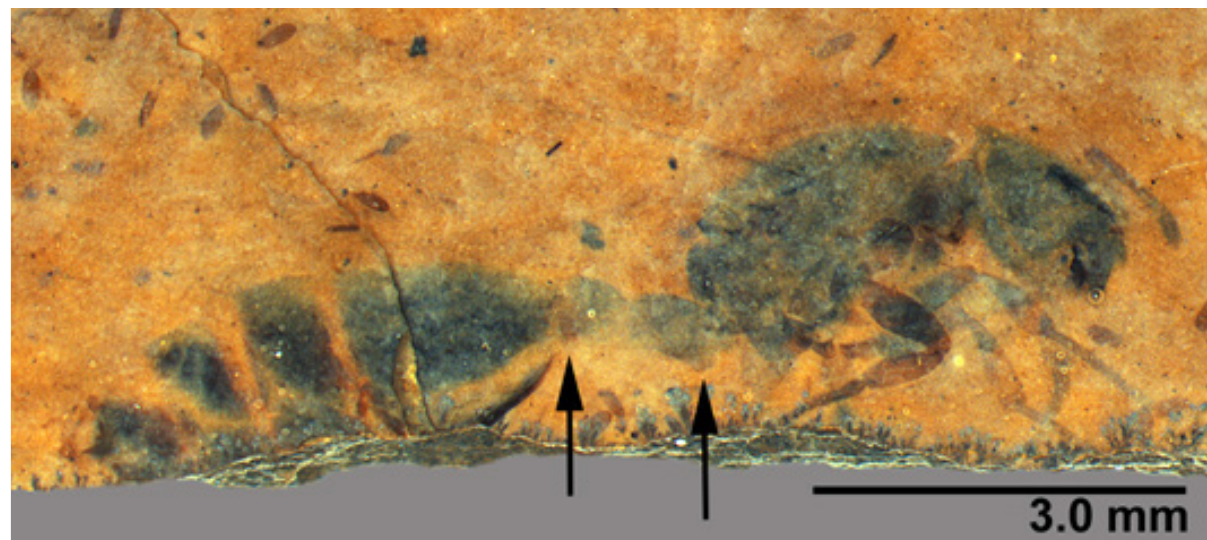
Fig 9 . Holotype queen, Crematogaster aurora (USNM# 609595). Arrows indicate the subpetiolar processes found on both the petiole and postpetiole.